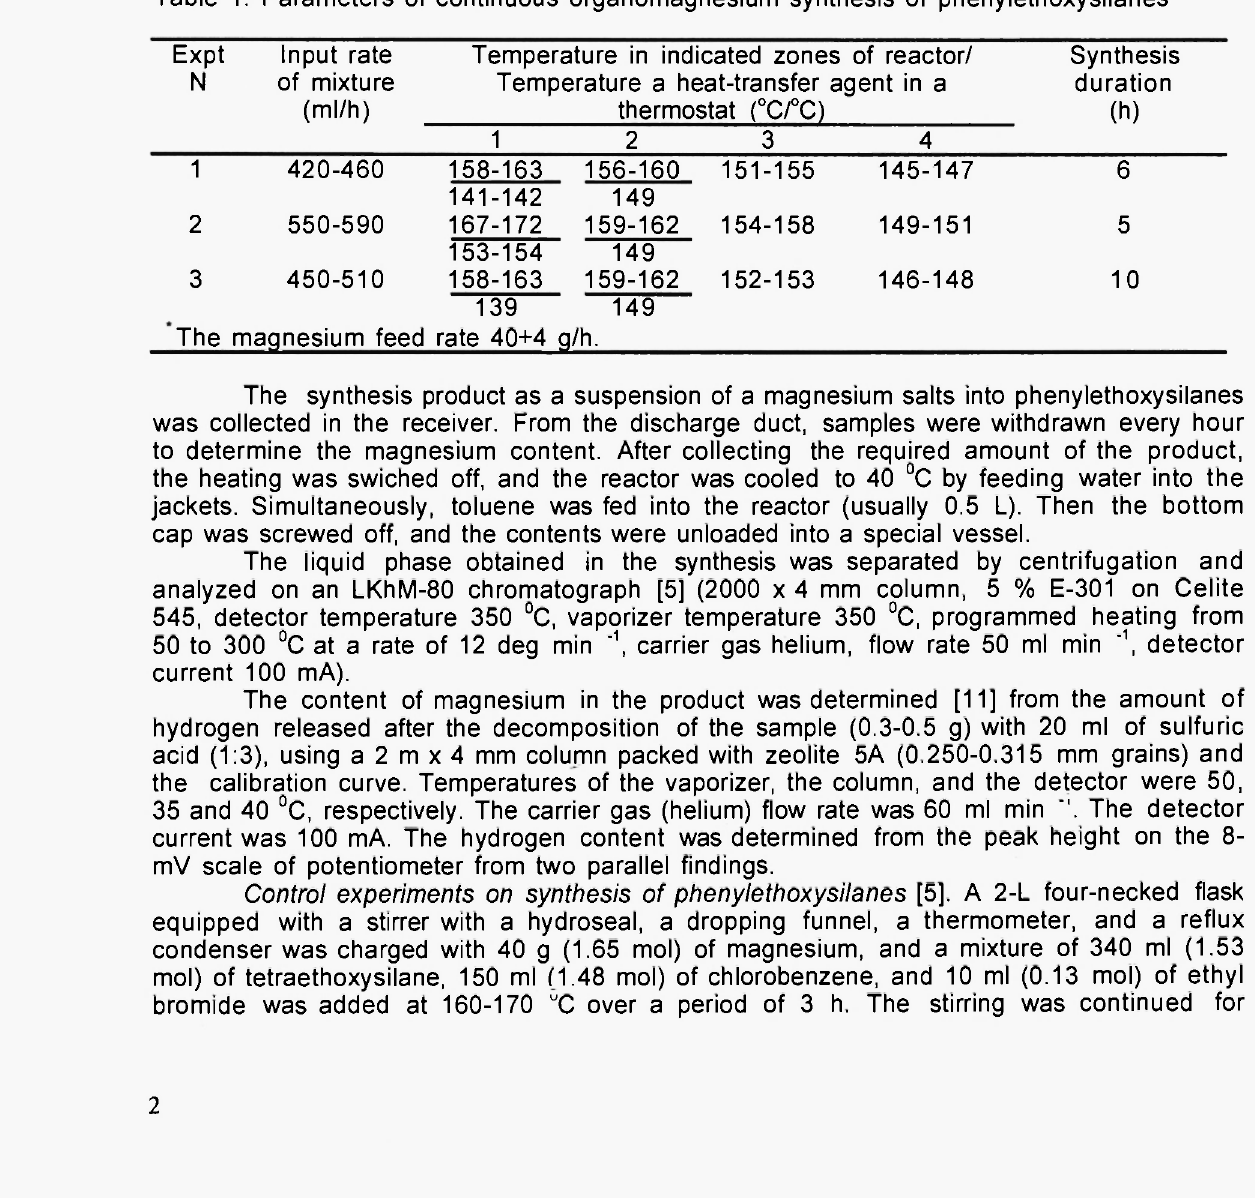
Table 1: Parameters of continuous organomagnesium synthesis of phenylethoxysilanes' Expt Input rate Temperature in indicated zones of reactor/